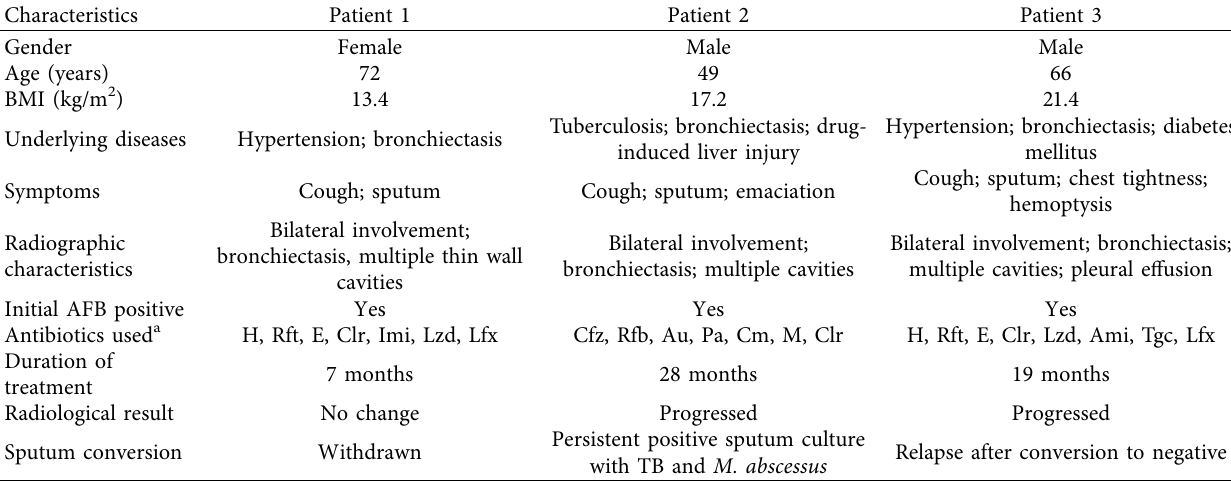
Figure 1: Timeline of antibiotic usage and date of M. abscessu s isolation. Triangle filled with white indicates that the strain was susceptible to clarithromycin at day 3, whereas yellow triangle represent clarithromycin resistance at day 3. All of the isolates were isolated from sputum. Table 1: Demographic and clinical features of patients in this